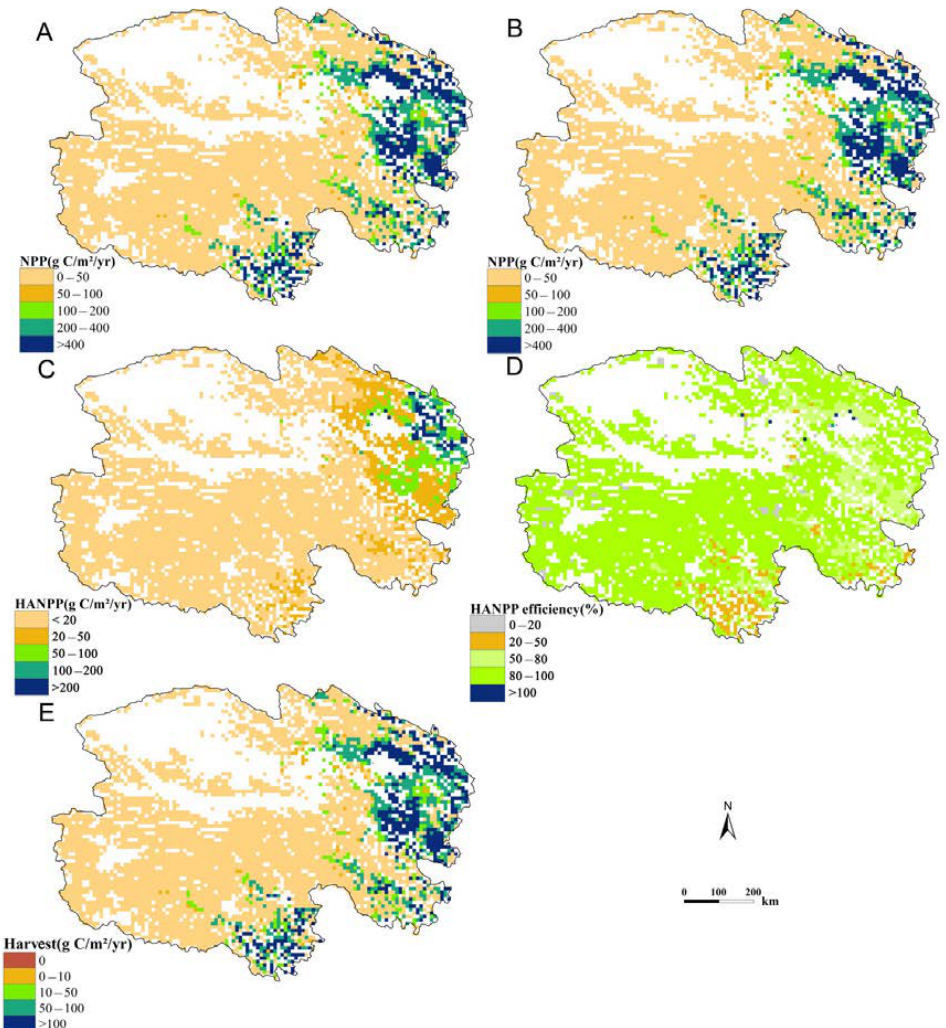
Figure 4. Spatial distribution of the ( A ) average annual potential net primary productivity (NPP pot ), ( B ) average annual actual net primary productivity (NPP act ), ( C ) average annual human appropriation of net primary productivity (HANPP), ( D ) average annual HANPP efficiency and ( E ) average annual harvest in Qinghai grasslands in the period of 1979 to 2018. Table 1. NPP pot , NPP act , HANPP, HANPP efficiency, and harvest (consumed by livestock) at dif- ferent altitudes in Qinghai grasslands in the period of 1979 to 2018.